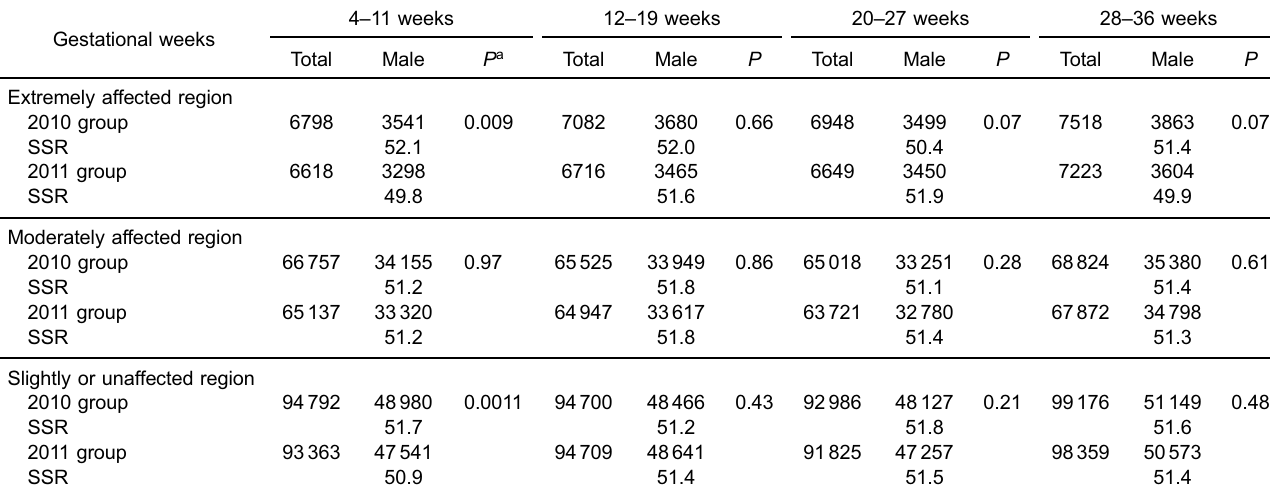
Table 2. Comparison of secondary sex ratio (SSR) of all singleton babies between the 2010 and 2011 groups in each gestational period category and region Gestational